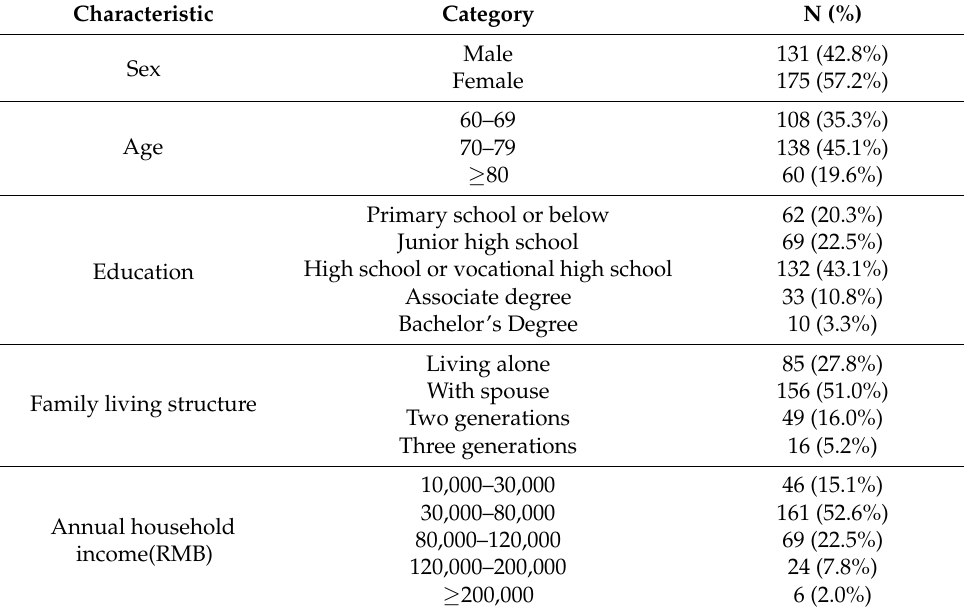
Table 4. Basic information statistics of the elderly interviewed (n =